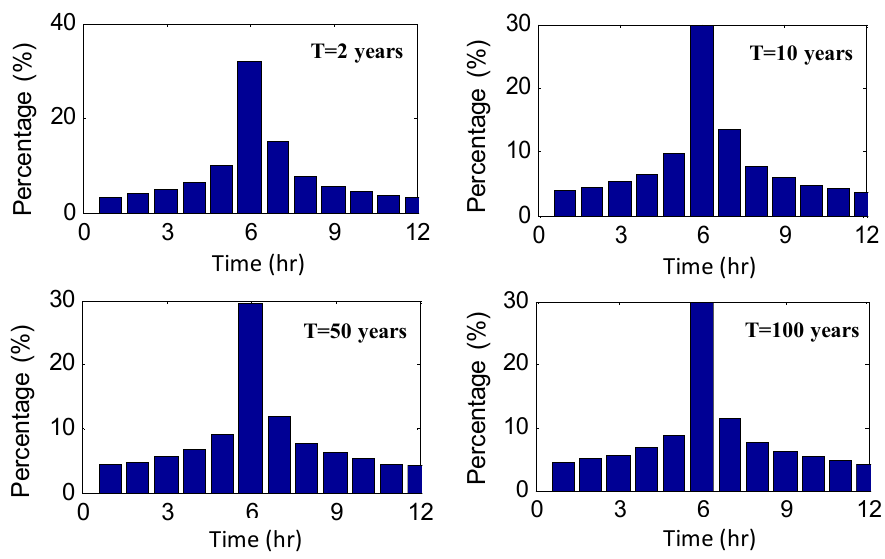
Figure 7. The design hyetograph for 2 ‐ , 10 ‐ , 50 ‐ and 100 ‐ year return periods and 12 ‐ h duration.